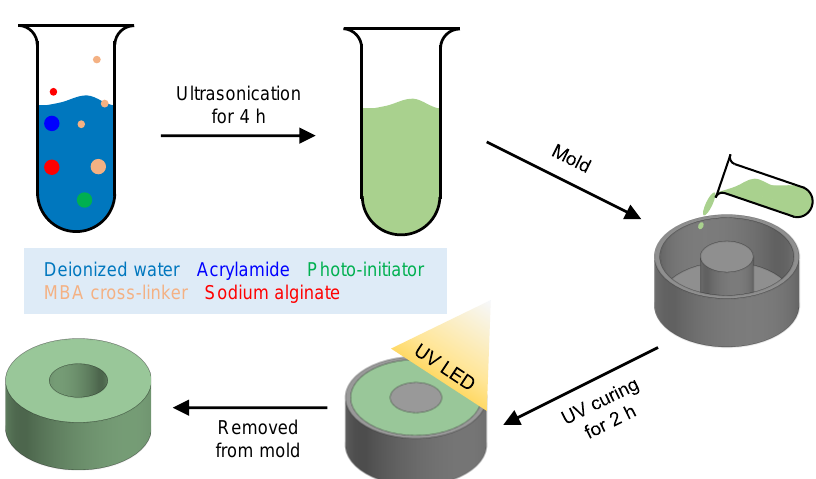
Figure 2. Steps involved in the fabrication of